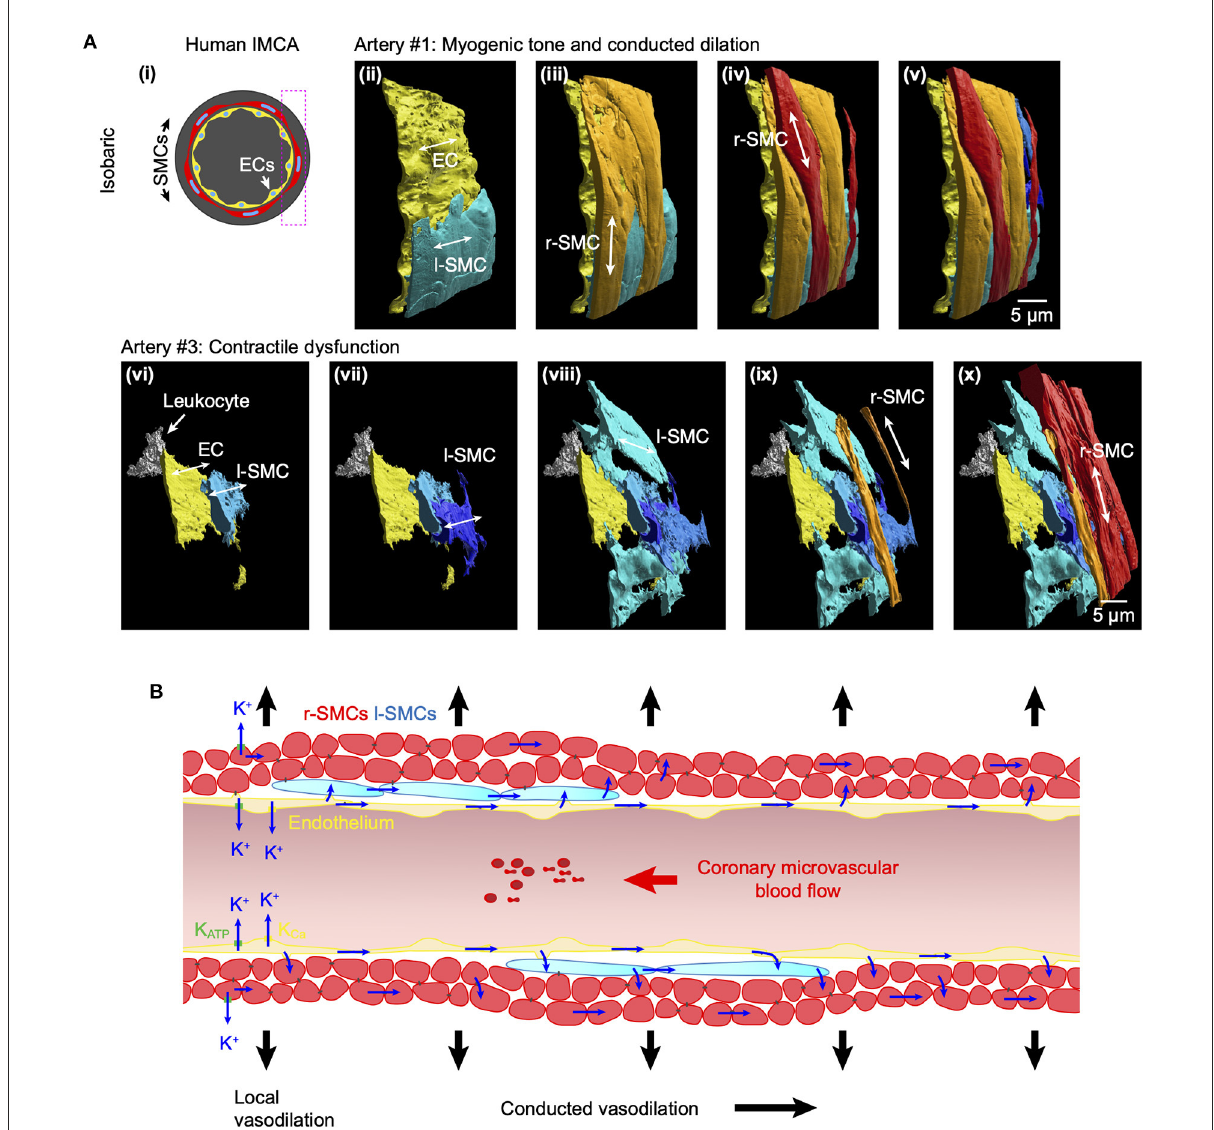
FIGURE12 Arrangement of SMCs in human RA-IMCAs with and without contractile function. (A) Not all human IMCAs developed myogenic tone, but cell-cell contacts were always visible between ECs, r-SMCs and l-SMCs. Pressurized human IMCAs (i) were fixed and processed for SBF-SEM. Artery #1 is shown here from the rear, with sequence of added cell types (ii–v) . Artery #3 did not develop myogenic tone, had missing ECs and was fibrotic. Despite this, ECs made contact with l-SMCs, many of which made contact with each other and then ultimately the r-SMCs in the outer surface (vi–x) . An inflammatory cell (leukocyte) is attached to the endothelium. (B) Schematic of conduction pathways in coronary IMCAs. In human, porcine and rat IMCAs l-SMCs are found between the endothelium and circumferentially-orientated radial r-SMCs. The